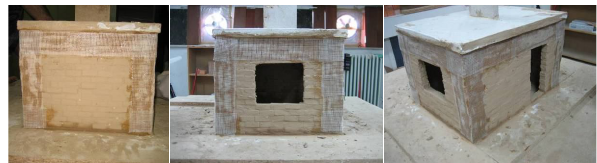
Fig. 9. Wire mesh strip